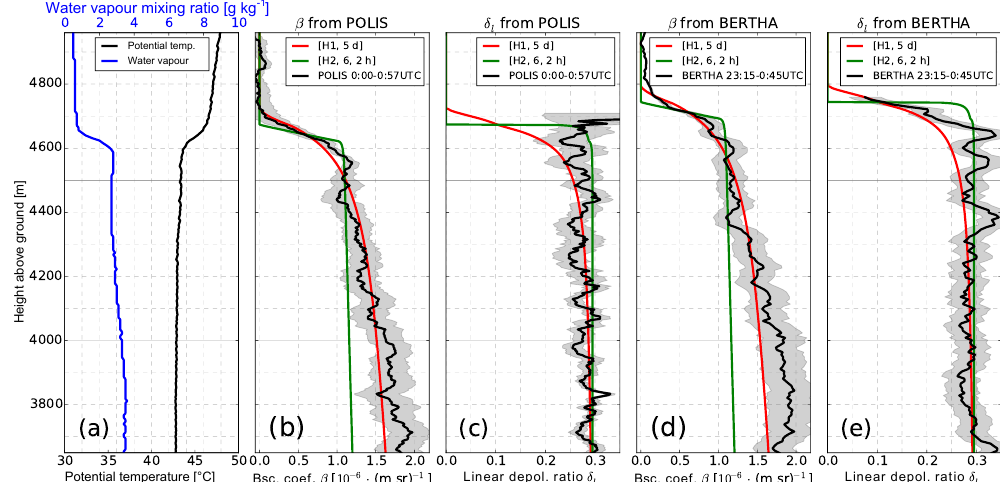
Figure 8. Vertical profiles over Barbados around 00:00UTC on 11 July 2013. (a) Profile of potential temperature (black) and water vapor mixing ratio (blue) from a radiosonde launched at 23:39UTC on 10 July 2013. (b) Particle backscatter coefficient β and (c) particle linear de- polarization ratio δ l at λ = 532nm from POLIS measured between 00:00 and 00:57UTC on 11 July 2013. (d) Particle backscatter coefficient β and (e) particle linear depolarization ratio δ l at λ = 532nm from BERTHA measured between 23:15UTC on 10 July 2013 and 00:45UTC on 11 July 2013. The shaded areas indicate the sum of the systematical and statistical uncertainties of the measured profiles. Corresponding modeled lidar profiles for H1 (red) and H2 (green) are shown. The SAL top heights of the modeled profiles were fitted to the measured β profiles (heights given in main text). A flat smoothing window of about 50m is used for the measured and modeled lidar profiles.